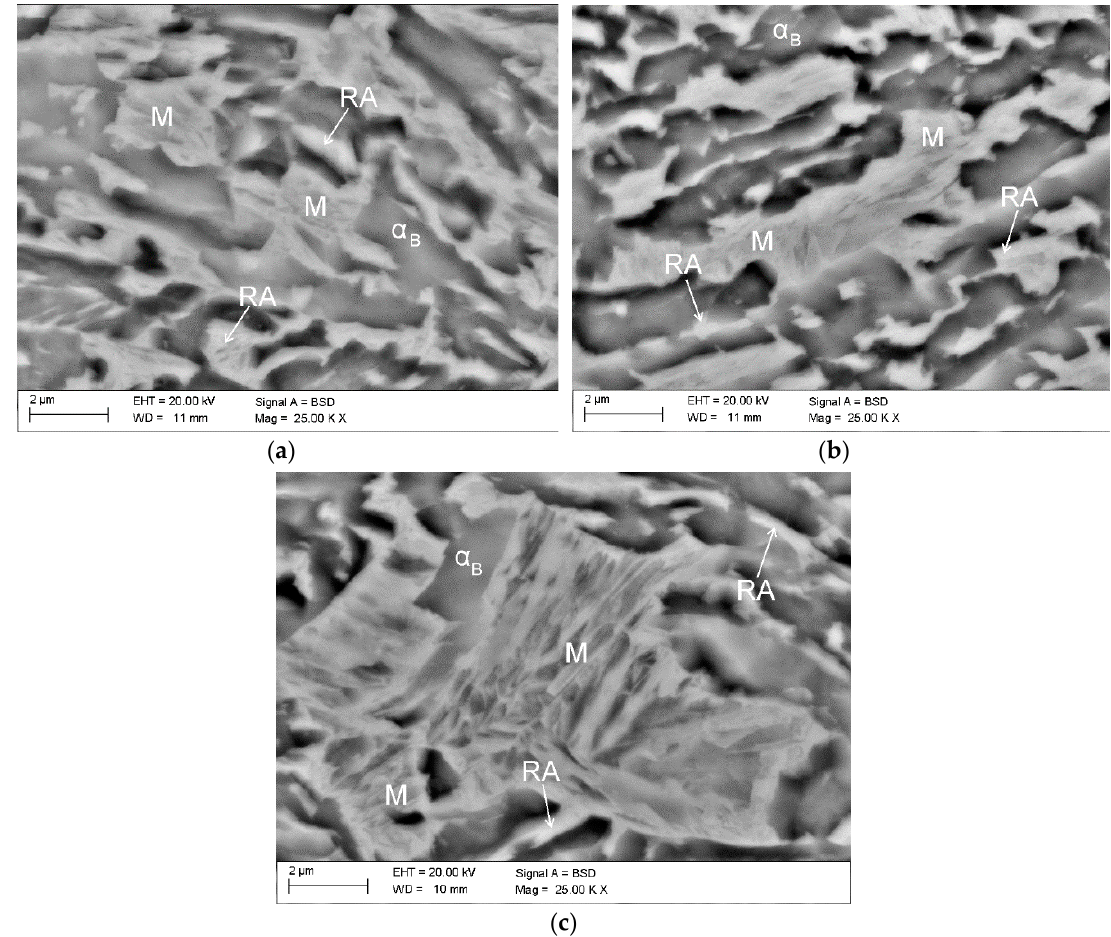
Figure 6. Microstructures showing the evolution of strain ‐ induced martensitic transformation of retained austenite (RA) obtained in interrupted tensile tests. Specimens deformed to elongation values: 5% ( a ), 10% ( b ), and up to rupture ( c ); M—martensite, α B —bainitic ferrite.